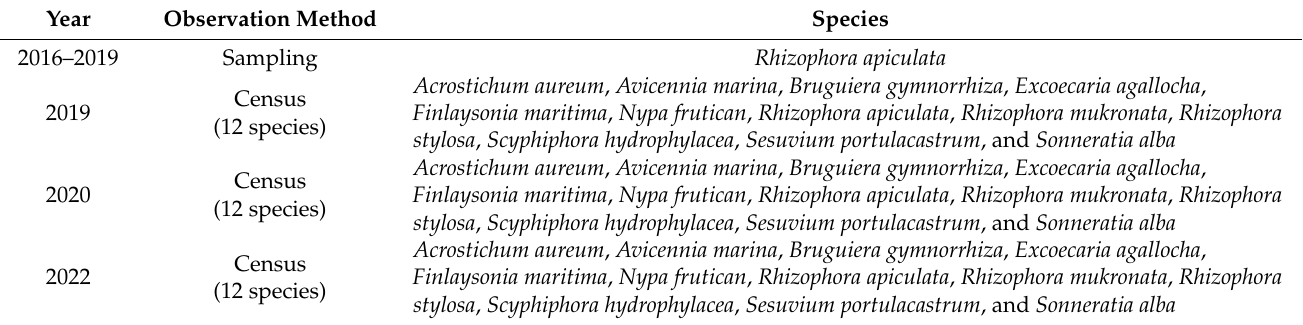
Table 3. Types of species found in the Lubuk Kertang restored area 2016–2022 planted with seedlings.